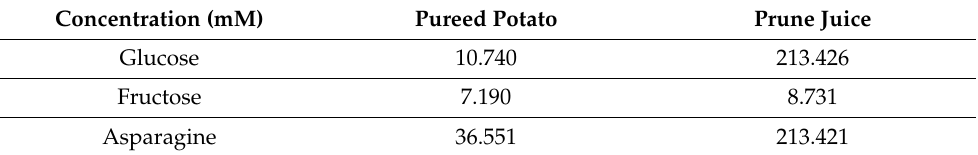
Table 1. Initial concentrations of glucose, fructose, and asparagine in pureed potato and prune juice. Concentration (mM) Pureed